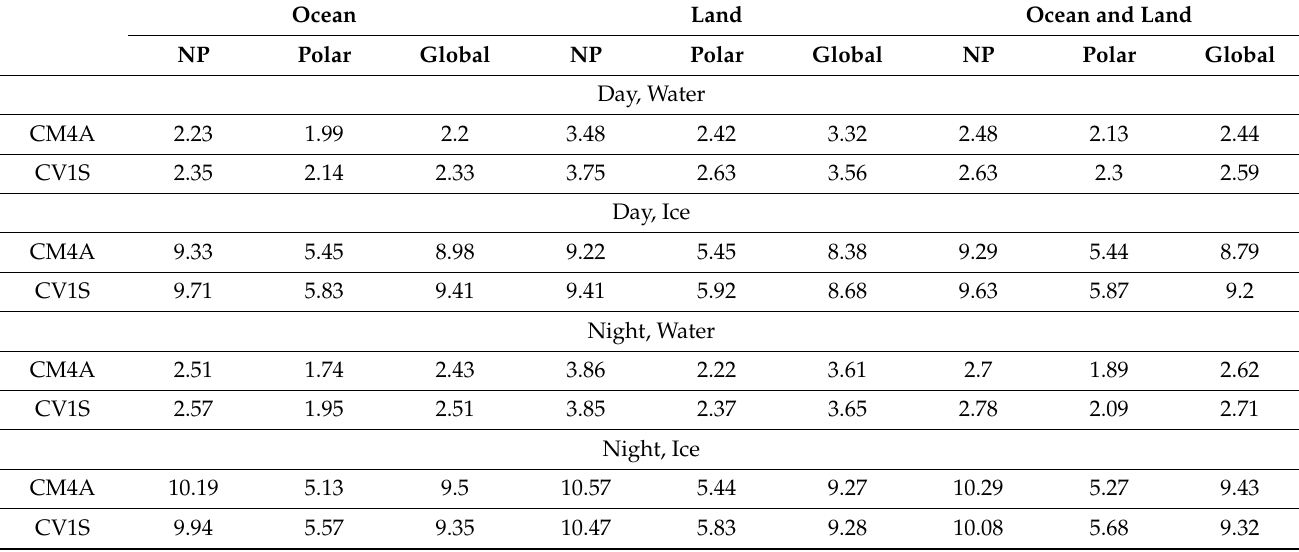
Table 4. Same as Table 2, except for the mean cloud effective height (km).